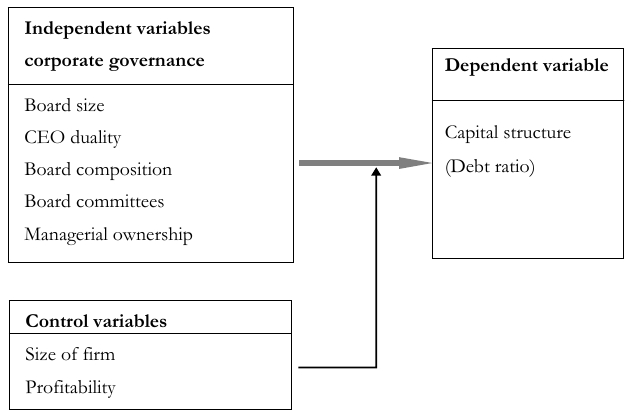
Fig. 1 - proposed research model. Source: